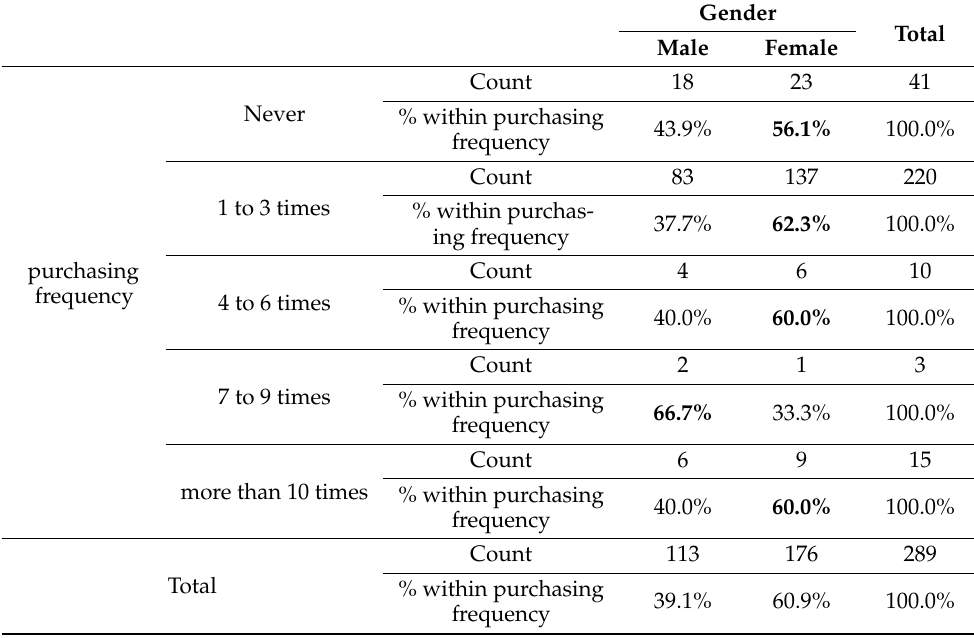
Table 6. Online purchasing frequency according to gender.